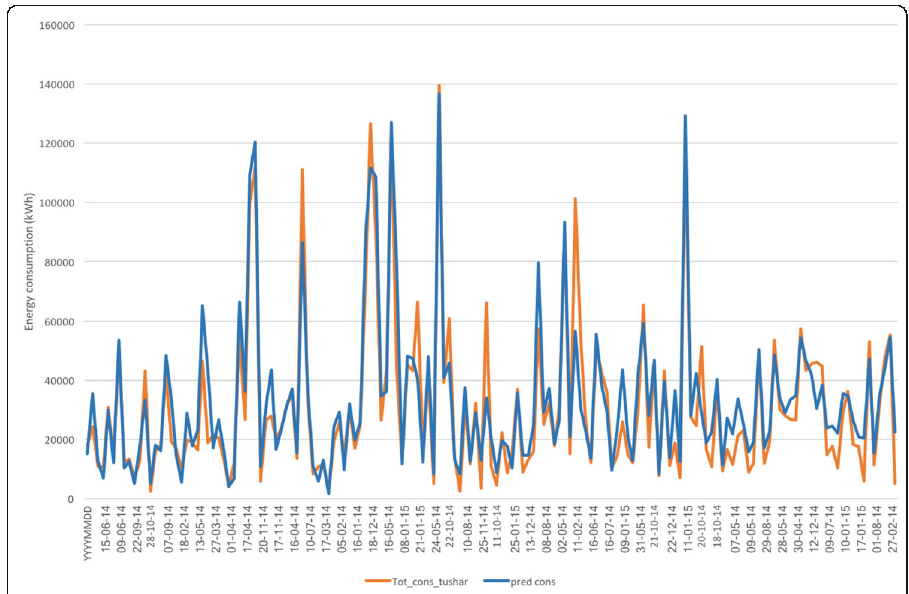
Fig. 4 Predicted values vs actual values of total energy consumption